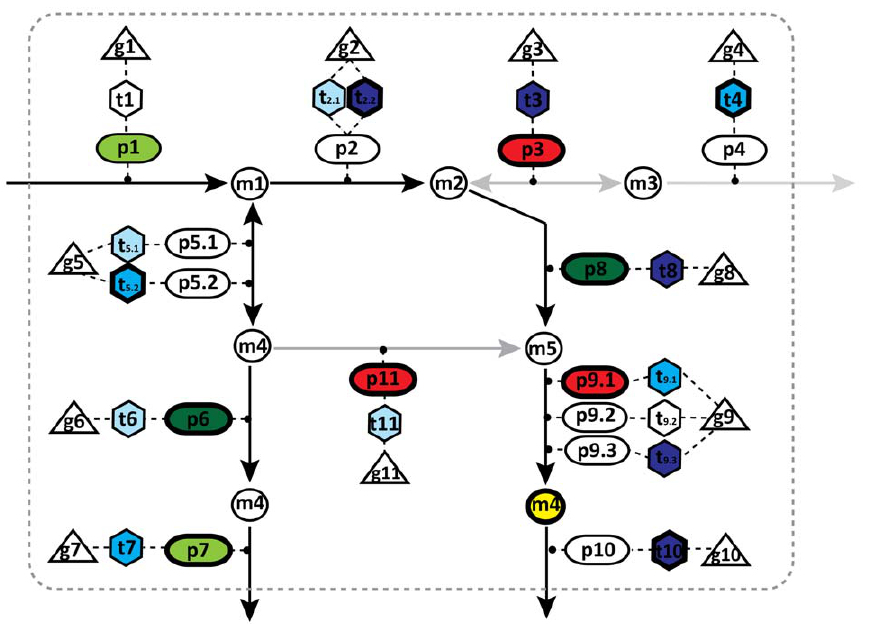
Figure 2. Illustration of the principles of the INIT algorithm. The hierarchical structure of GEMs is characterized by its gene-transcript-protein- reaction (GTPR) associations. In GEMs, each metabolic reaction is associated to one or more enzymes, which in turn are associated to transcripts and genes. Depending on the evidence for presence/absence of a given enzyme/gene in a cell type, a score can be calculated for the reaction(s) catalyzed by that enzyme. The HPA evidence scores are illustrated as red, light, medium and dark green representing negative, weak, moderate and strong evidence, respectively. The transcriptome evidence scores (GeneX), which are illustrated as red, light, medium, and dark blue representing low, medium and high expression, respectively. No evidence is present as white object. For some metabolites (yellow filled circle), metabolomic data are available to prove that they are present in the considered cell type. The aim of the algorithm is to find a sub-network in which the involved genes/ proteins have strong evidence supporting their presence in the cell type under consideration. This is done by maximizing the sum of evidence scores. All the included reactions should be able to carry a flux and all the metabolites observed experimentally should be synthesized from precursors that the cell is known to take up. The bold lines represent the resulting network after